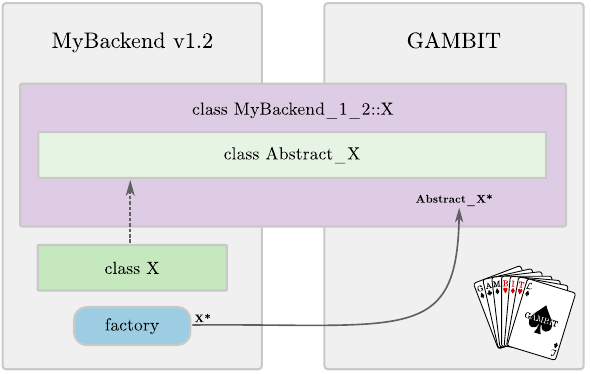
Fig. 4 Schematic diagram of the plug-in system generated by BOSS for the case where a backend library MyBackend 1.2 contains a sin- gle class X . For every constructor in X , a factory function returning a pointer to a new X instance is added to the library. An abstract base class Abstract_X and an interface class MyBackend_1_2::X are gen- erated and added to both the backend library and GAMBIT . The inter- face class MyBackend_1_2::X wraps a pointer to Abstract_X . The factory function initialises this pointer with an instance of X ,